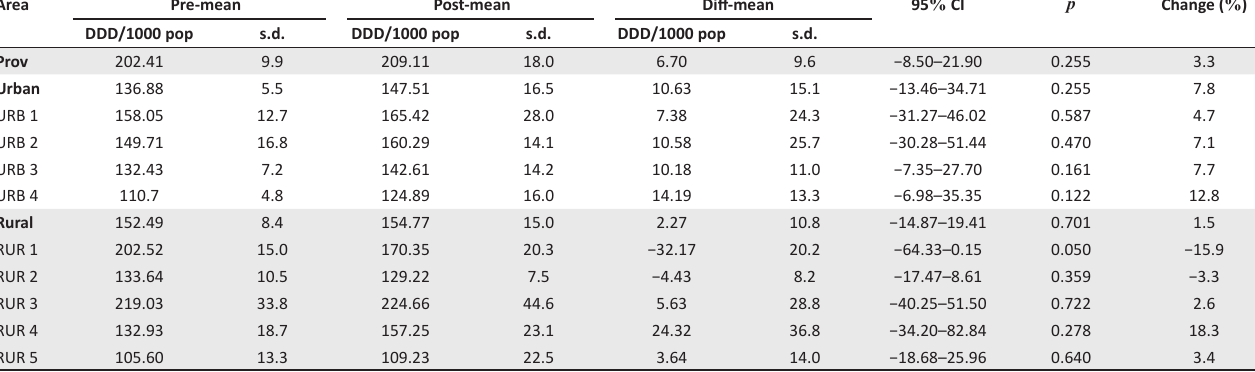
TABLE 1: Mean consumption per quarter and change in consumption of sodium valproate pre- and post-policy implementation, 2018–2020. Area Pre-mean Post-mean Diff-mean 95 % CI p Change ( % ) DDD/1000 pop